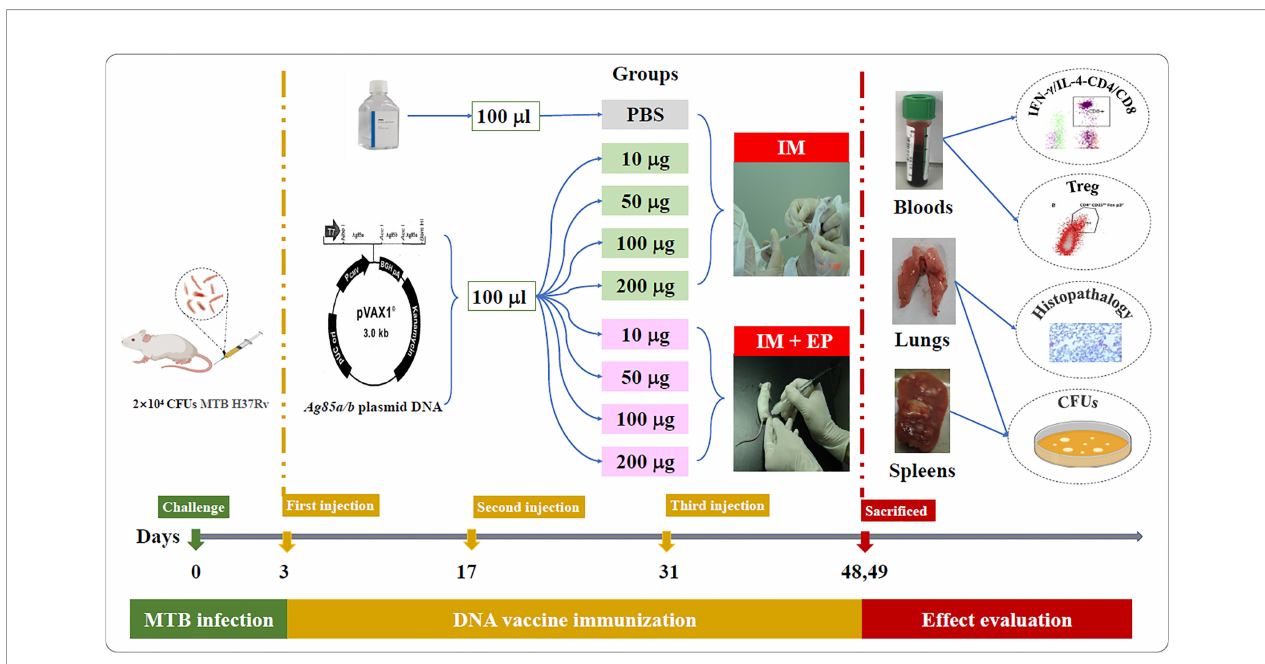
FIGURE 1 | The fl ow chart of DNA vaccine treatment on the mouse TB model. IM, intramuscular injection; EP,